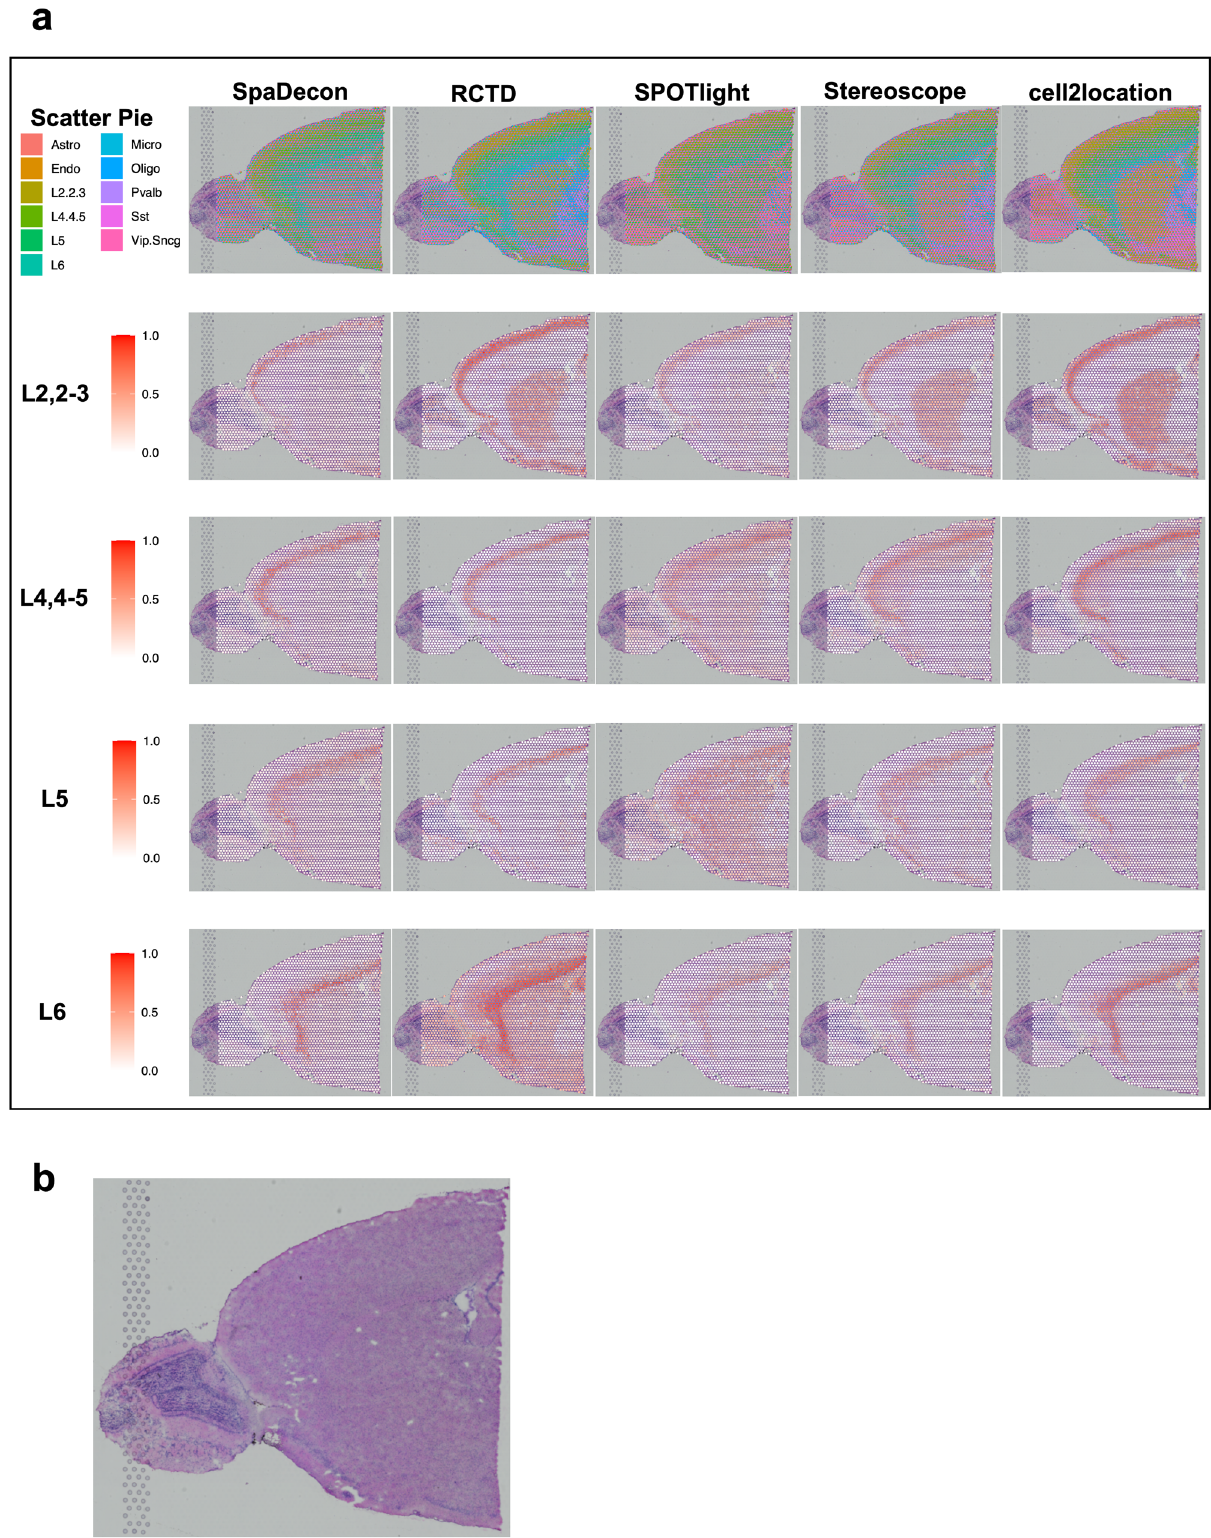
Fig. 2 Cell-type deconvolution results for 10X Visium mouse brain serial section 1 (sagittal-anterior) data. a Scatter pie plots displaying the cell-type proportion estimates of SpaDecon, RCTD, SPOTlight, Stereoscope, and cell2location at each spot, along with heatmaps showing the estimated distributions of the cortical layer-speci fi c glutamatergic neurons. Full names of abbreviated cell types are provided in Supplementary Table 3. b Low-resolution histology image of anterior mouse brain tissue section from which Visium data were